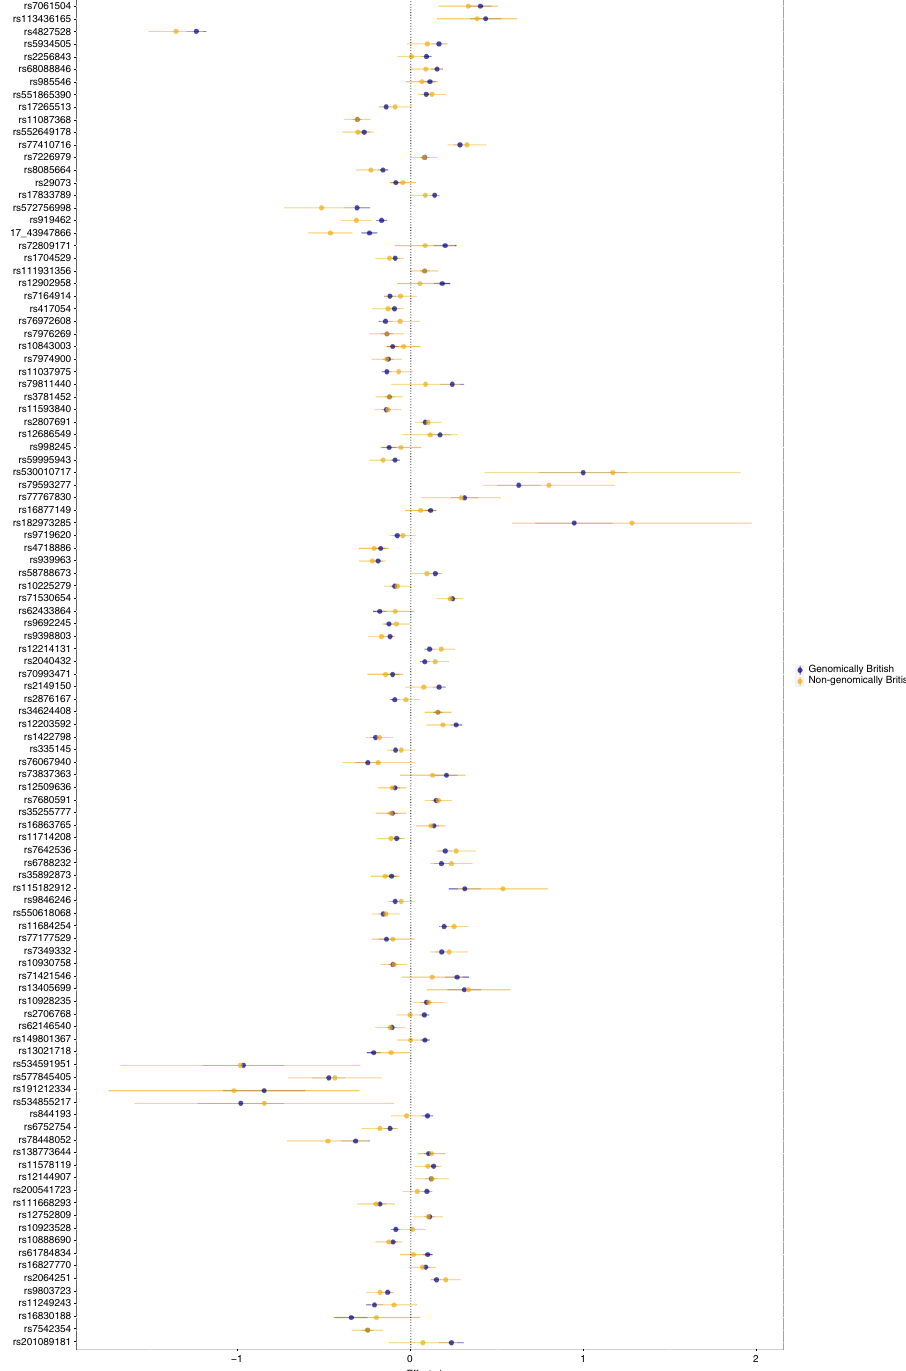
Fig. 2 Forest plot of SNP effects in genomically and non-genomically British cohorts. The fi gure reports the effect and con fi dence intervals for each distinct SNP in the genomically British (in blue) and non-genomically British (in yellow). None of the SNPs showed signi fi cant differences between the two